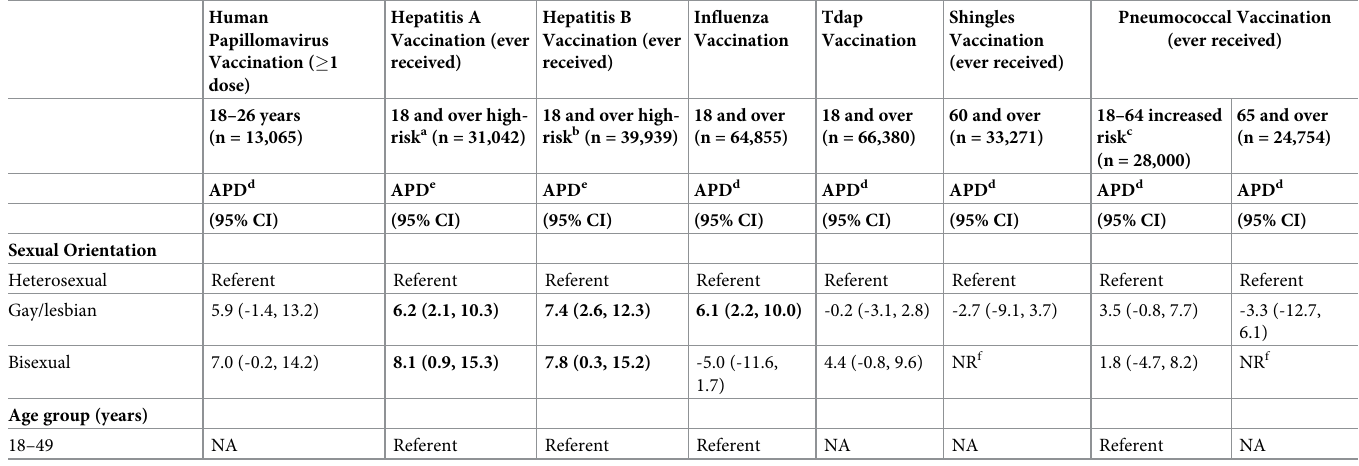
Table 4. Multivariable logistic regression analysis among persons aged � 18 years in the United States who reported receiving selected vaccines by self-identified sexual orientation, demographic characteristics, health conditions, health behaviors, and healthcare access–National Health Interview Survey,